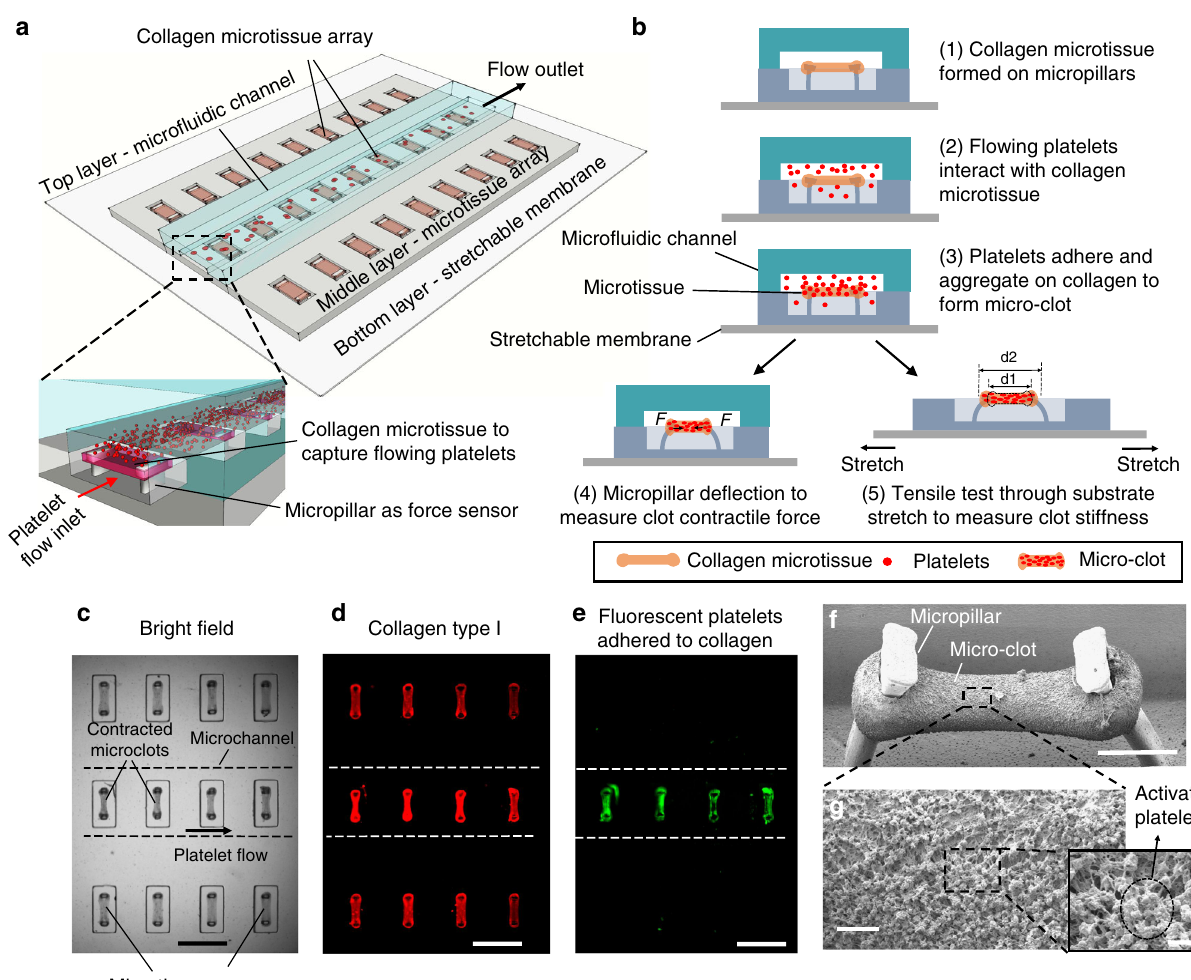
Fig. 1 clotMAT system setup and microclot array formation under platelet fl ow. a clotMAT system contains a top micro fl uidic channel layer, a middle PDMS substrate containing the microtissue array and a bottom stretchable membrane. An array of exposed collagen microtissues capture fl owing platelets to form individual microclots. b Schematic diagram shows microclot formation process and the principles of mechanical property measurement. Microclot contractile force is measured by micropillar de fl ection and stiffness is measured by substrate stretching-enabled tensile testing. A region of the microtissue array shown by bright fi eld image ( c ), and immuno fl uorescence staining of the collagen ( d ) and adhered platelets ( e ) in the same region. Scale bar is 800 µ m. Note that the platelet fl ow ran through the middle row of the collagen microtissue array, resulting in the adhesion of fl uorescent-labeled platelets (green) only in this row. f SEM image of a microclot formed between the heads of a pair of micropillars. Obvious micropillar de fl ection is noticeable. Scale bar is 200 µ m. g Zoom-in view of the microclot surface shows numerous platelets trapped in a fi brin meshwork. Scale bar is 10 µ m. Inset shows activated single platelets. Scale bar is 2 µ m. PDMS poly(dimethylsiloxane), SEM scanning electron